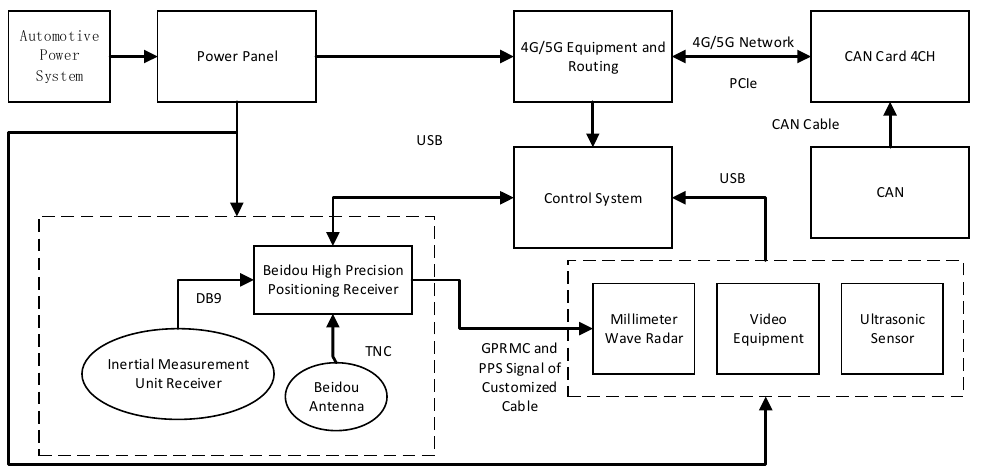
Figure 2. Hardware architecture of the on-board computing unit.